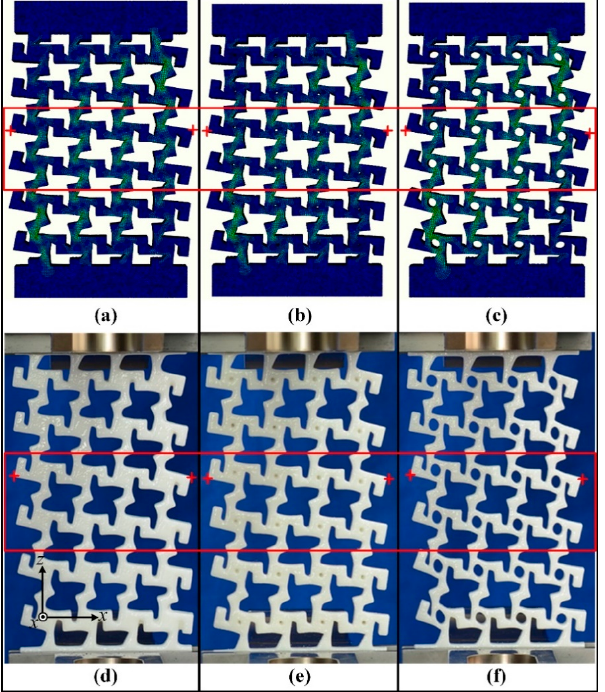
Figure 3. Models in Abaqus with hollow circle diameters of d (cid:48) = ( a ) 0, ( b ) 1, and ( c ) 3 mm; 3D-printed specimens for tensile tests with hollow circle diameters of d = ( d ) 0, ( e ) 1, and ( f ) 3